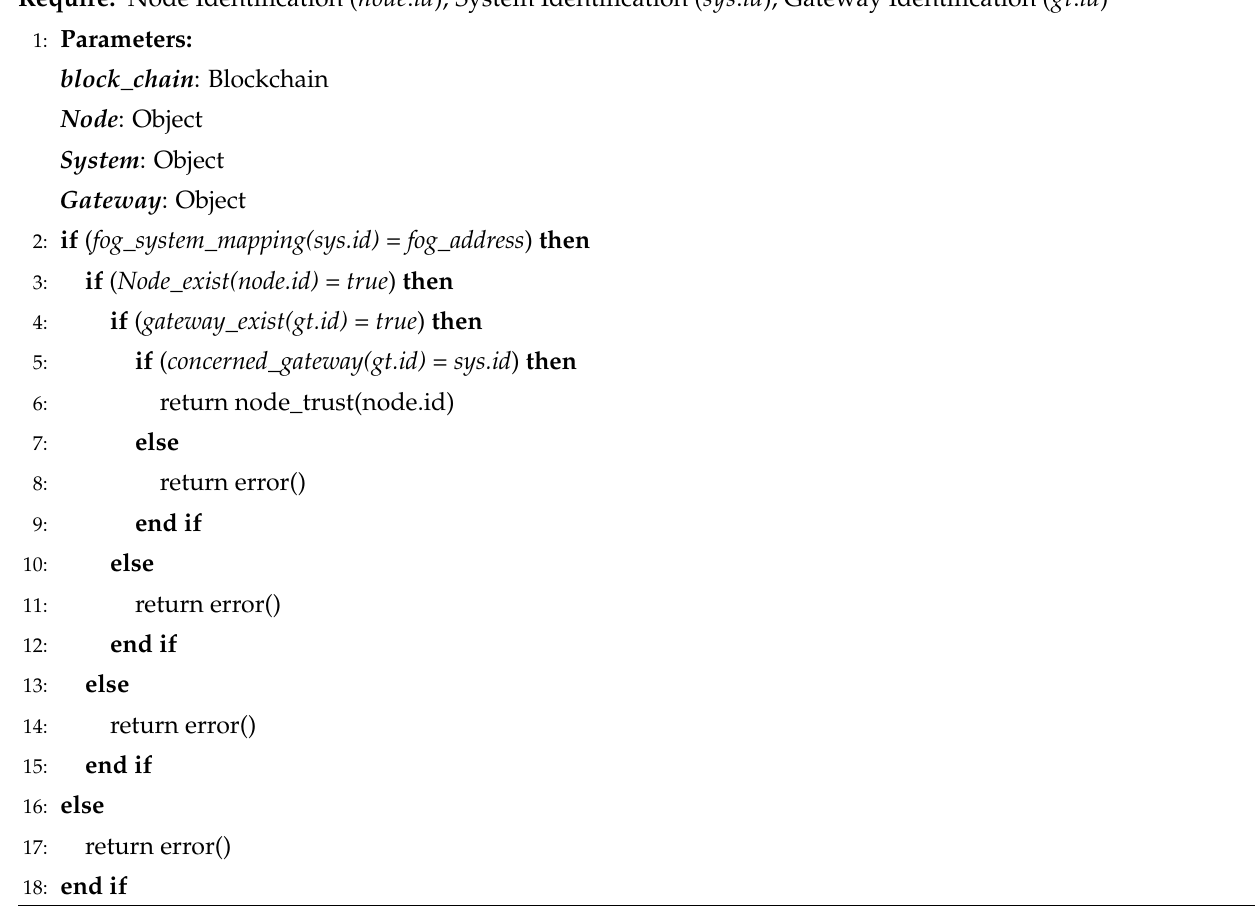
Algorithm 4 Node trust verification rules for smart